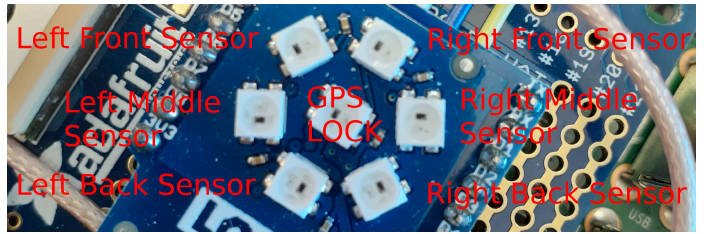
Figure 5. Raspberry Pi RGB LED status lights for GPS lock and motes’ connection status